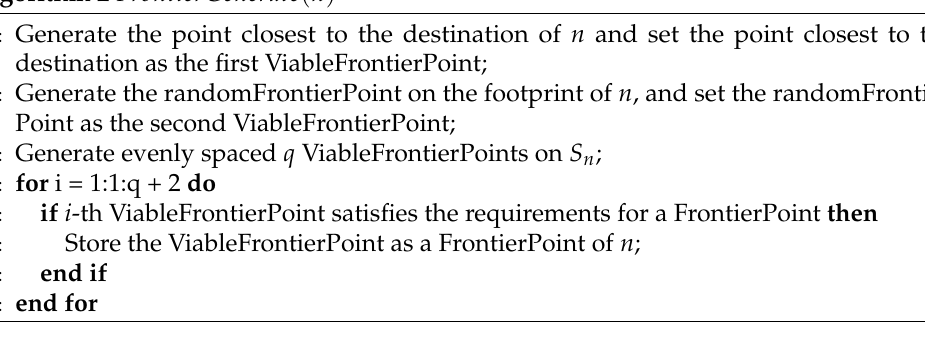
Algorithm 2 FrontierGenerate ( n